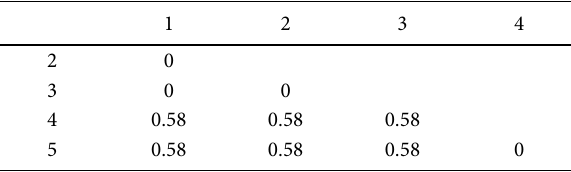
STRUCTURE plot of SRAP molecular markers (Fig- ure 5) revealed more detailed information on the genetic affinity of the studied populations. It also revealed the